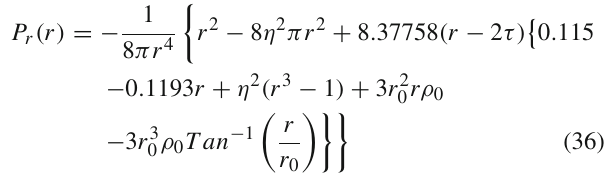
Fig. 6 NEC with respect to r ( kpc ) and η is plotted by using ρ 0 = 0.004 kpc − 2 , r 0 = 2 kpc , r th = 1 kpc , k 1 = k 2 = 1, α = 0 . 8, β = 0 . 001 and τ = 2 . 5 for URC